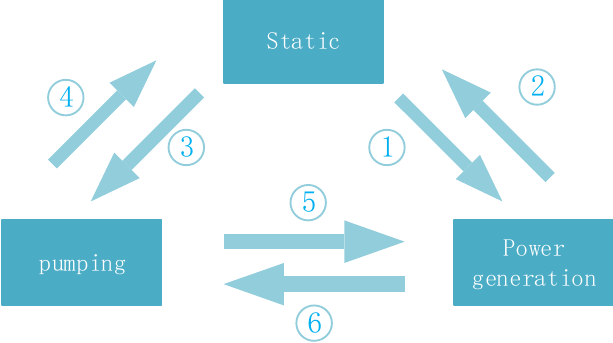
Figure 3. Pumped storage unit operating state transfer diagram.